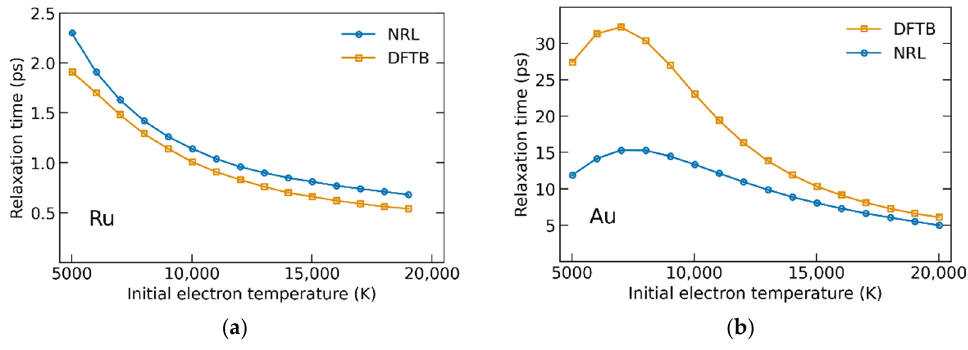
Figure 5. ( a ) Electron–ion relaxation times in ruthenium ( a ) and gold ( b ), calculated using two different TB parametrizations: NRL (blue) and DFTB (orange).